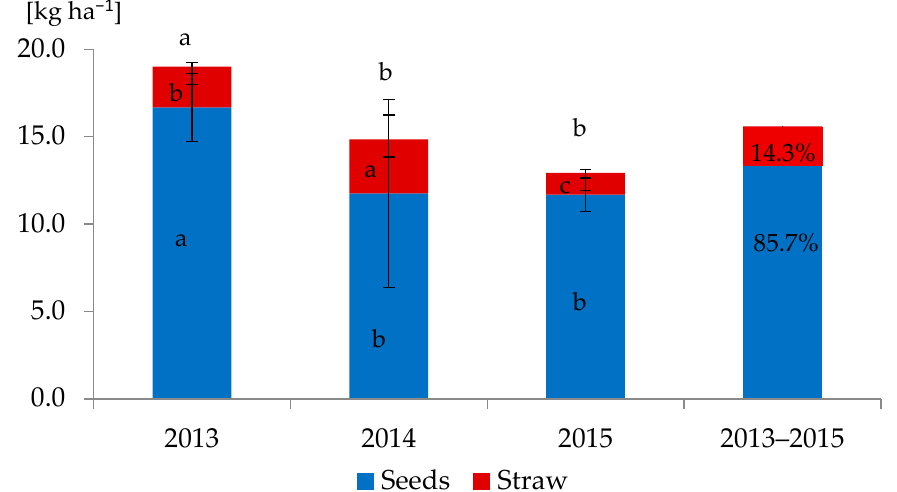
Figure 4. Phosphorus accumulation kg ha − 1 in whole faba bean plant (average for years). The vertical line atop bar is SD for that mean. Different letters indicate a significant difference (Tukey’s multiple range test).